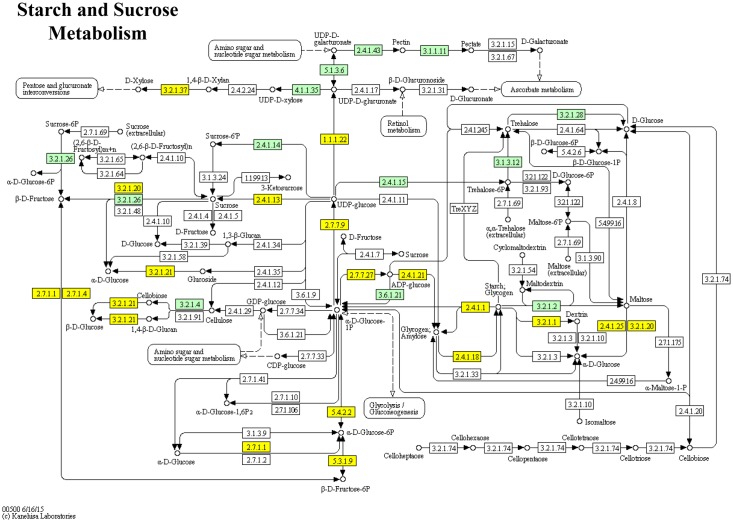
Proteins enriched in starch and sucrose metabolic pathways.The enzymes marked with yellow and blue color are proteins enriched in rice starch granule proteome.